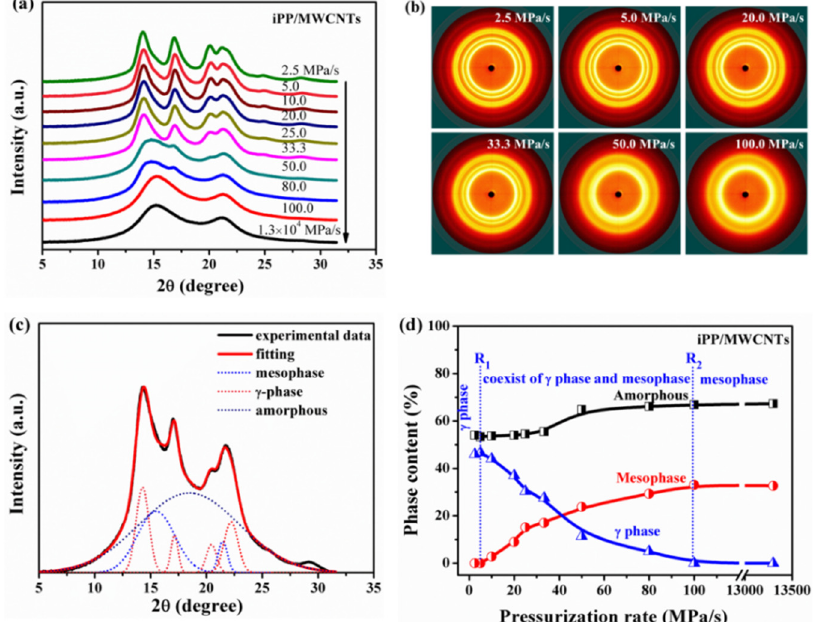
Figure 4. ( a ) Selected 1D WAXD profiles and ( b ) 2D WAXD patterns of multi-walled carbon nanotubes (iPP/MWCNTs) samples pressurized to 2.0 GPa at different pressurization rates; ( c ) the fitting curves of WAXD of amorphous, mesomorphic, and γ -phases; ( d ) contents of amorphous, mesomorphic, and γ -phases as a function of pressurization rate.